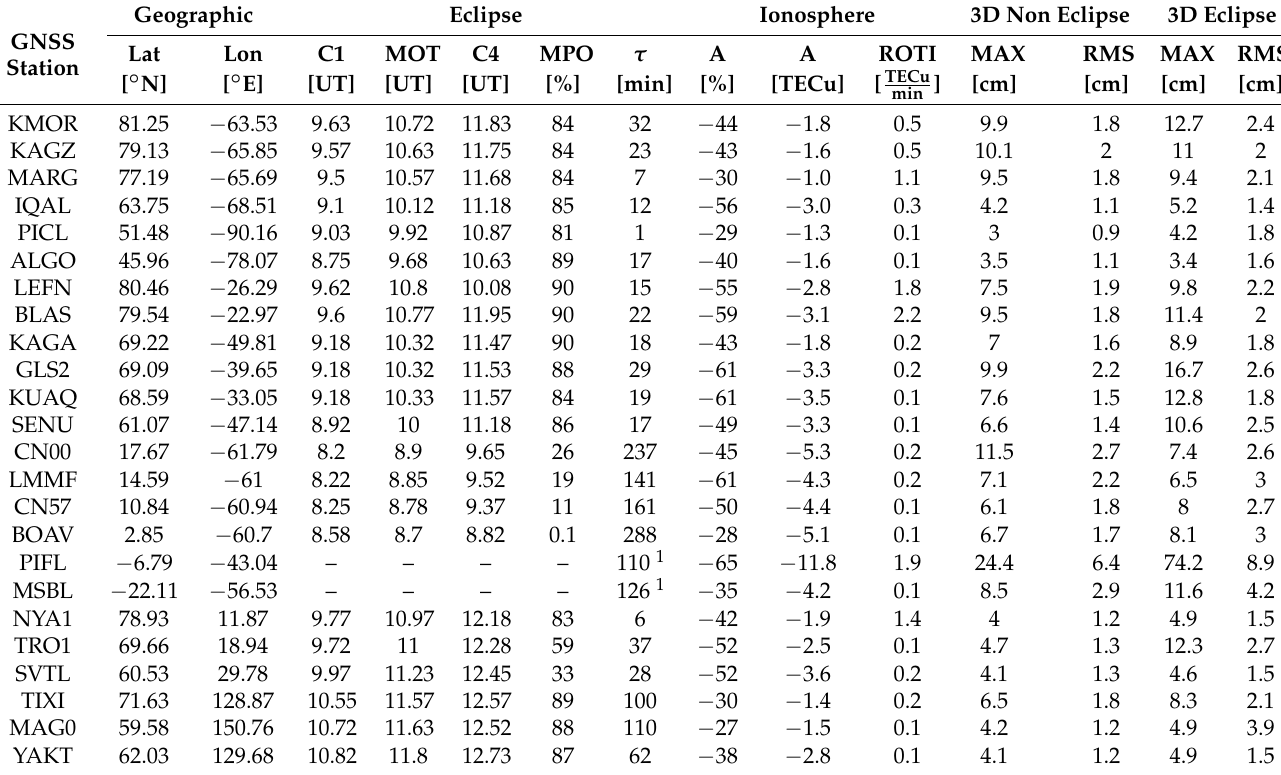
Table 1. Detail about the GNSS stations analyzed, their location, eclipse condition, magnitude and change in VTEC at each station. Eclipse characteristics (time and maximum obscuration) for the 24 selected GNSS stations. Further, we have also estimated eclipse conditions at the ionospheric height of 350 km by the method suggested by Verhulst et al. [21]. Ionosphere, 3D eclipse, and 3D non-eclipse values are between 8 and 14 UT. In 3D non-eclipse: MAX refers to the maximum 3D positioning error of the reference days, and we calculate RMS by taking all the values of the reference days between 8 and 14